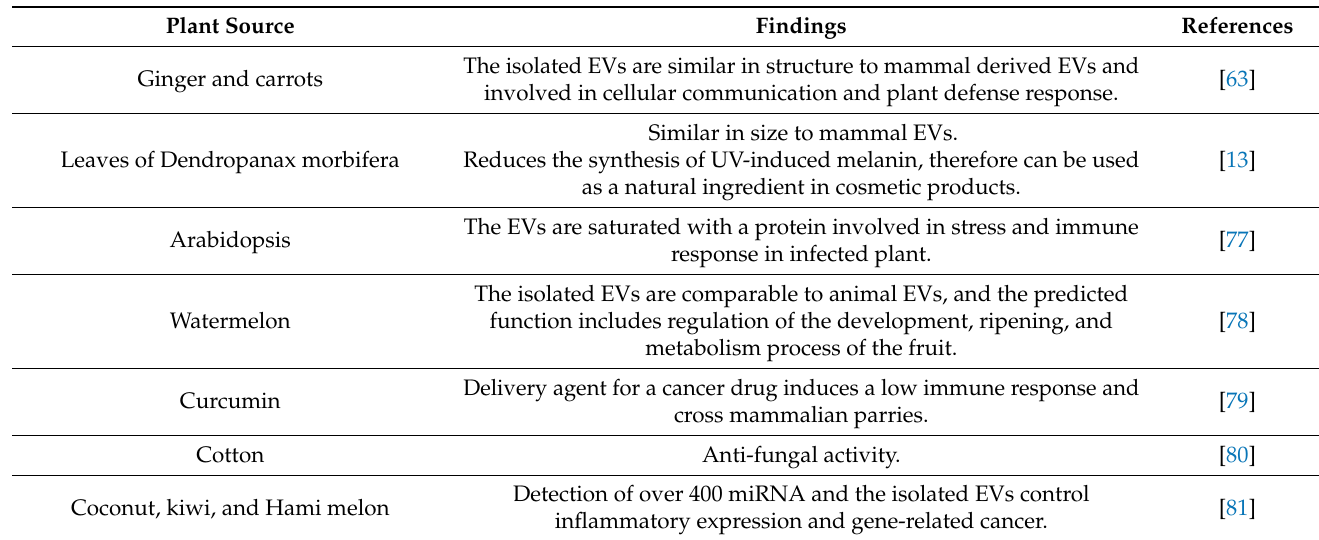
Table 2. Assortment of isolated plant-derived EVs and their characterization compared to mammal- derived